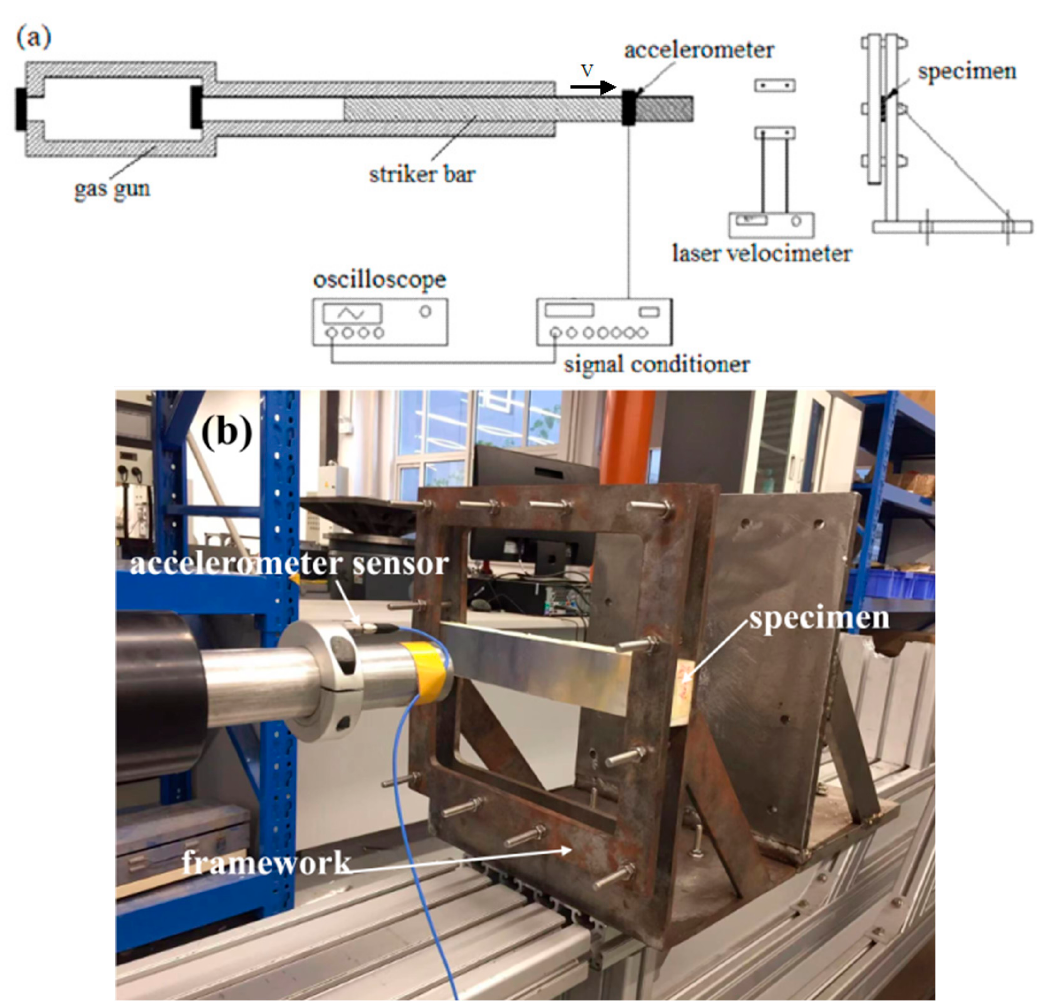
Figure 2. The impact apparatus for the dynamic experiments: ( a ) schematic graph; ( b ) experimental Figure 2. Theimpactapparatusforthedynamicexperiments: ( a )schematicgraph;( b )experimental apparatus.